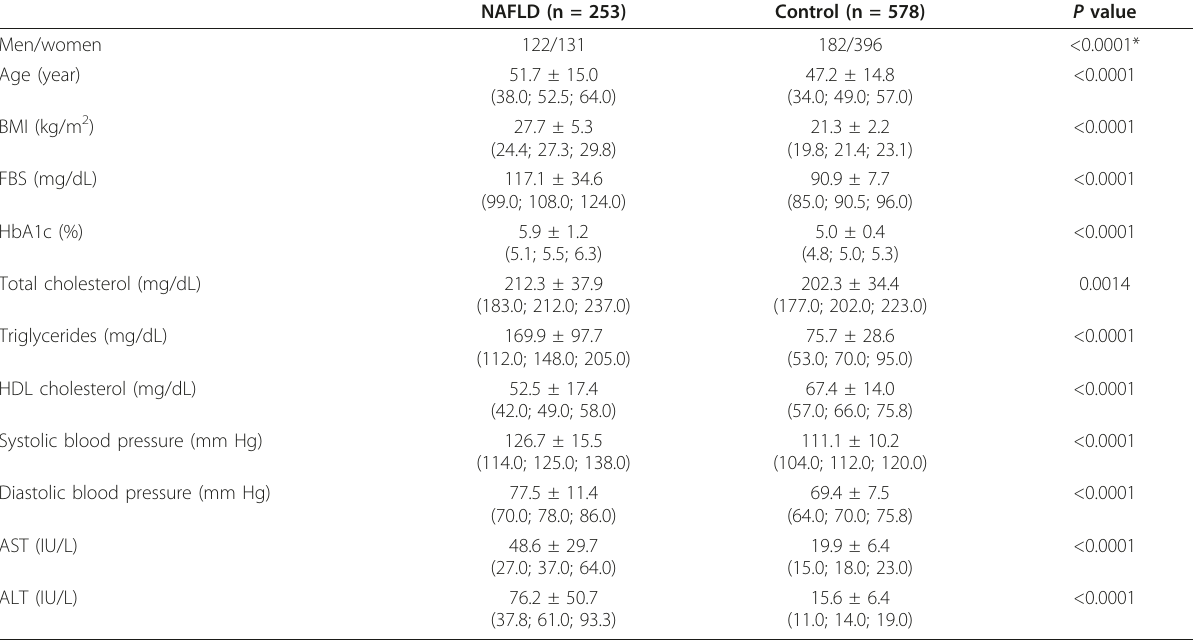
Table 1 Clinical characteristics of the patients with NAFLD and control